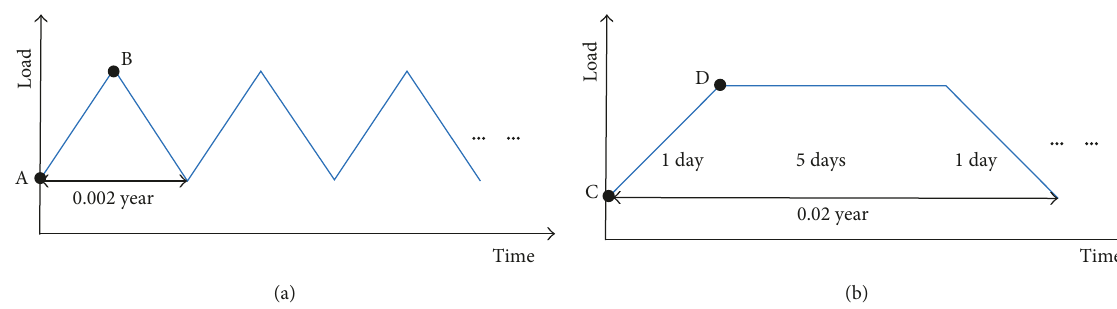
Figure 15: Time history: (a) load cases of vertical, transverse, and longitudinal accelerations and (b) load case of